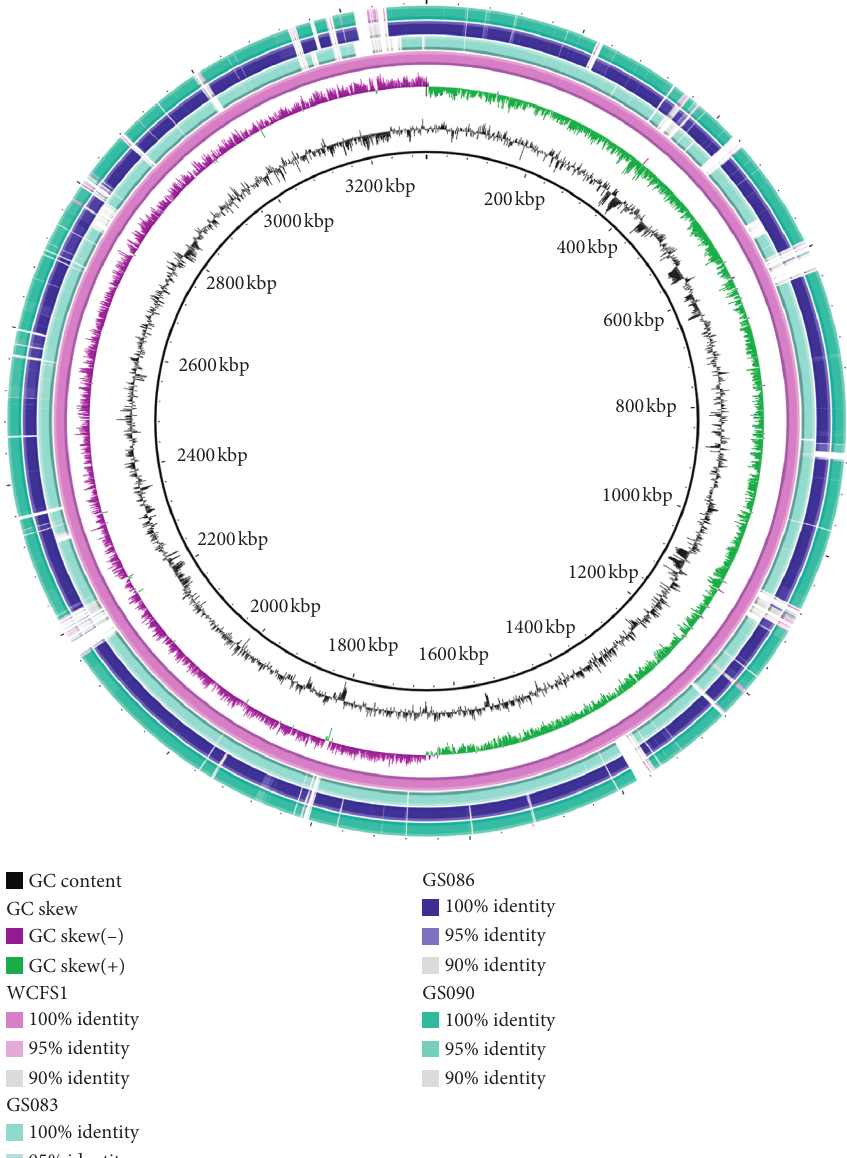
Figure 4: BLASTrings of CDS sequences of L . plantarum GS083, GS086, GS090, and WCFS1 mapped onto the genome of the L . plantarum